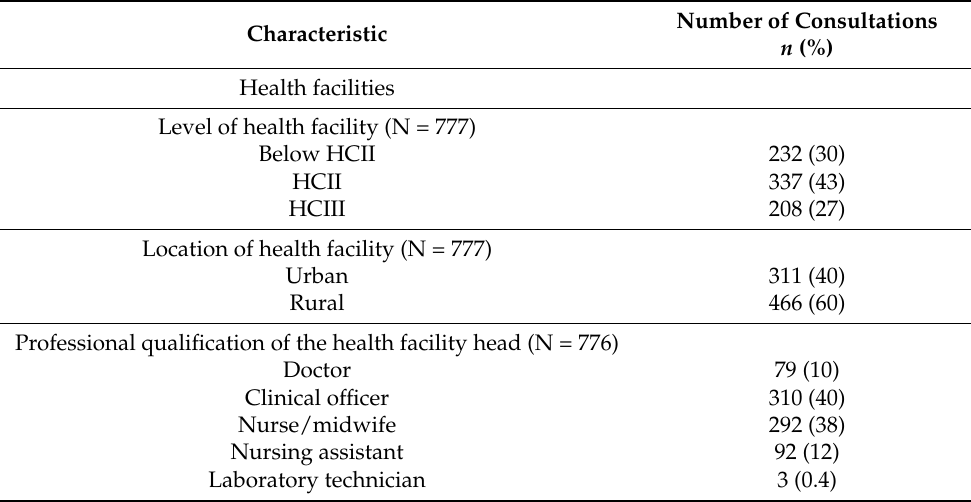
Table 2. Number of consultations by health facility and health worker